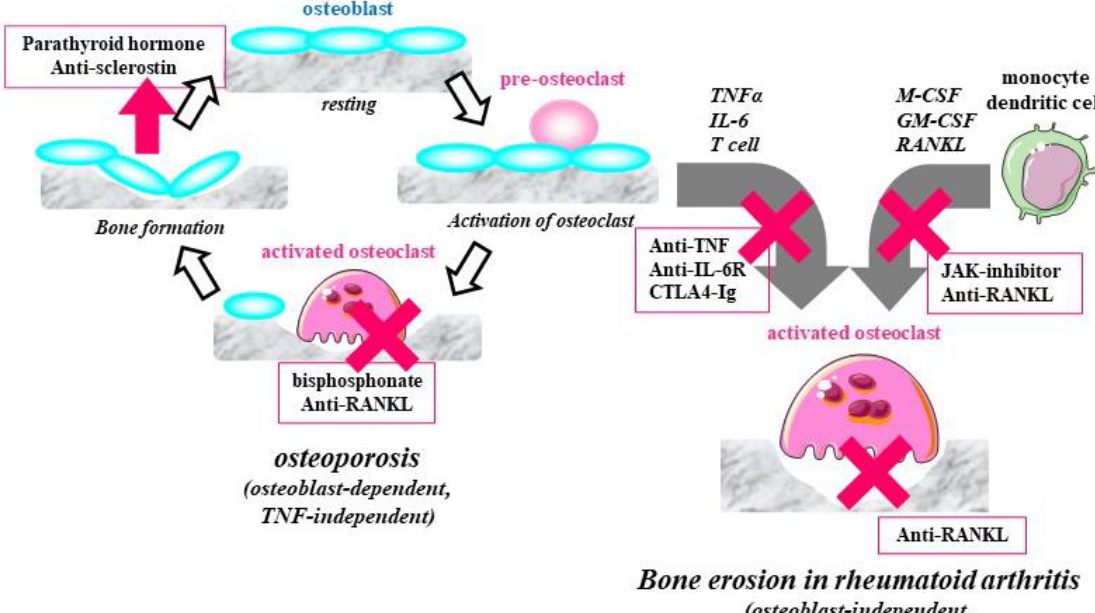
Figure 3. Osteoporosis and bone erosion in rheumatoid arthritis. Osteoclasts in the rheumatoid synovium deviate from normal bone metabolism by stimulation with tumor necrosis factor (TNF), IL-6, and T-cells, and cause bone destruction by the maturation and activation of osteoclasts in an osteoblast-independent manner, leading to bone erosion.